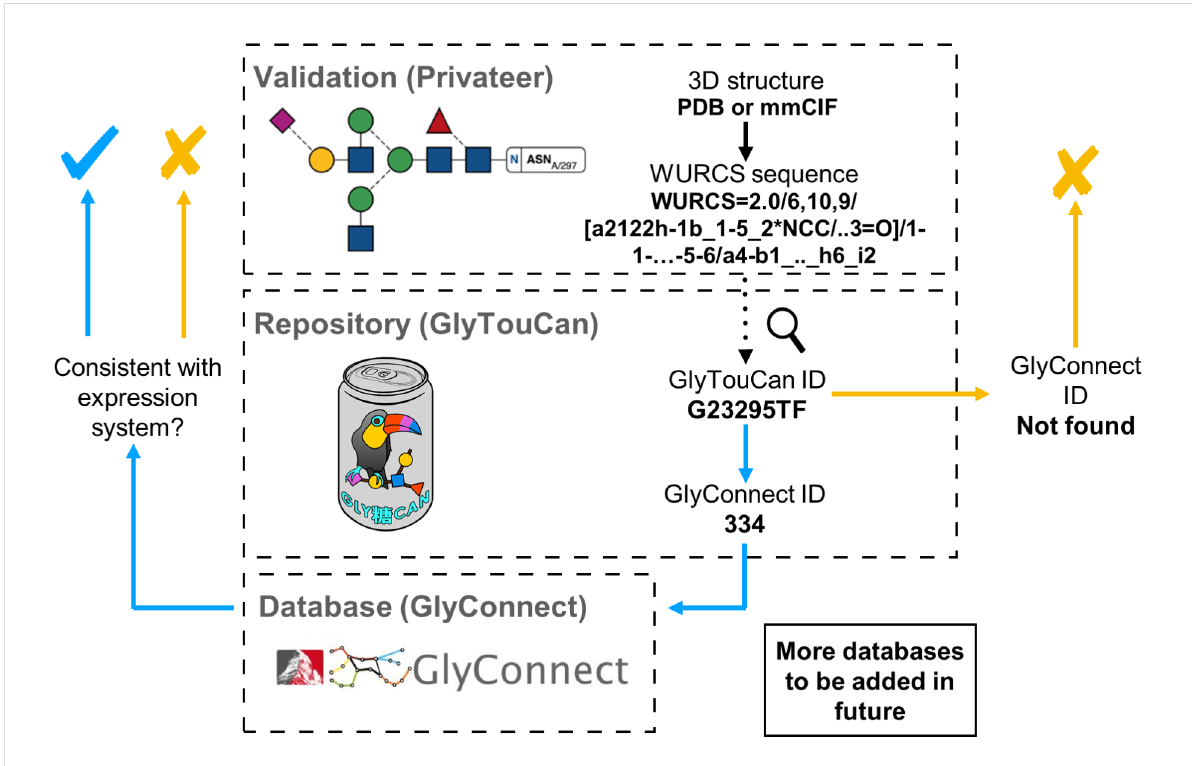
Figure 2: A roadmap of the software development project that allows structural biologists to quickly obtain detailed information about specific glycans in glycoprotein models from glycomics/glycoproteomics databases. The GlyTouCan (https://glytoucan.org/) and GlyConnect (https:// glyconnect.expasy.org/) logos have been reproduced here under explicit permission from their respective authors.